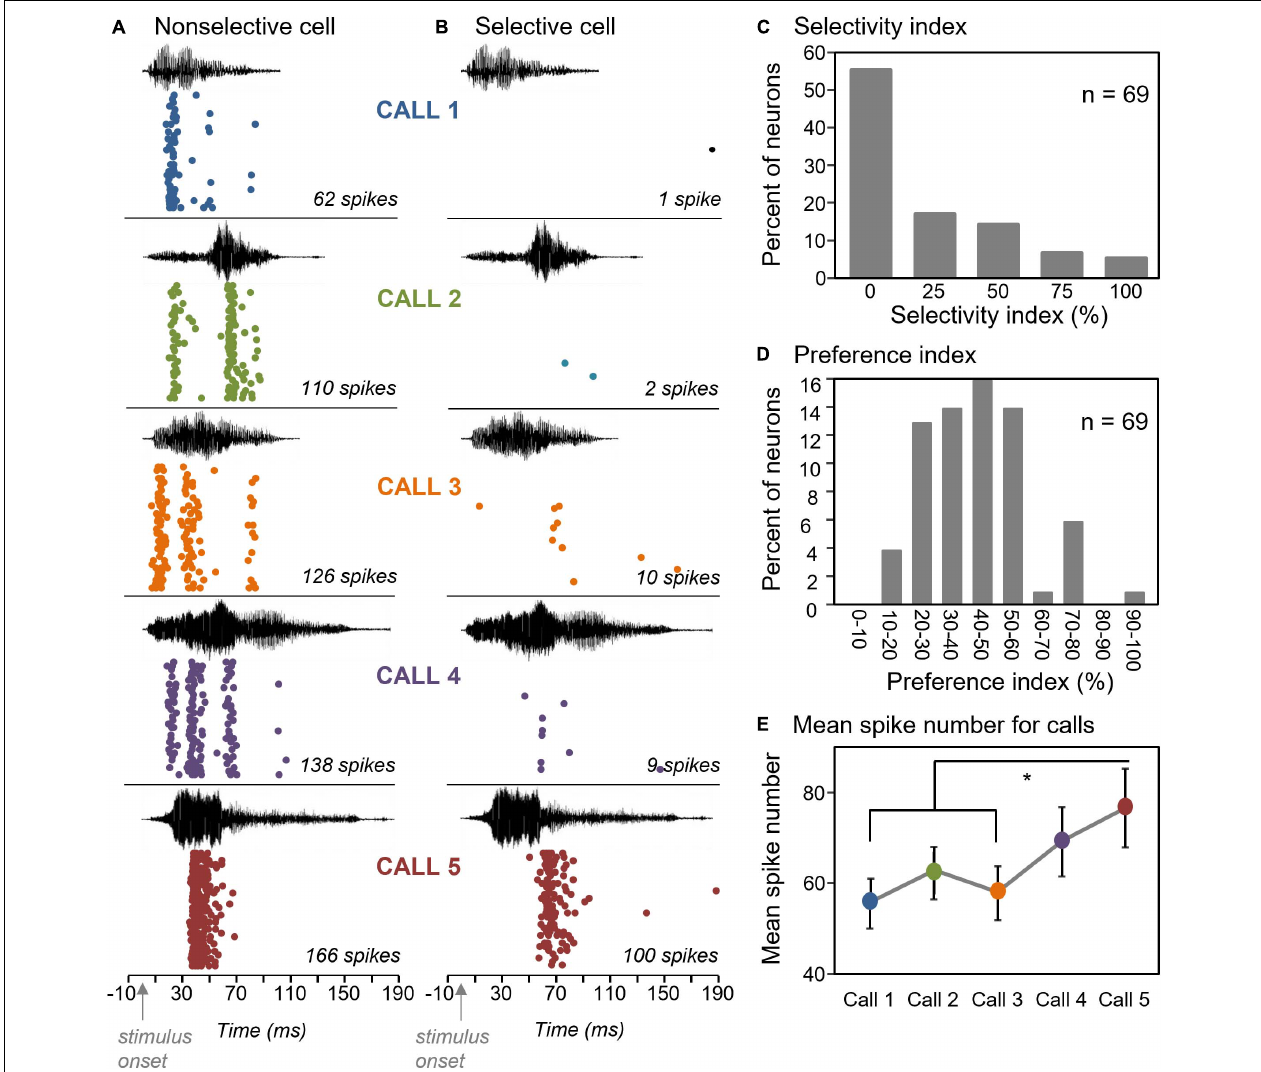
FIGURE 2 | Selectivity of IC neurons for the five BBVs. (A) Raster plots of a neuron that responded to all five BBVs. (B) Raster plot of a neuron that responded robustly only to Call 5. (C) Selectivity index across a group of 69 neurons illustrating a low degree of selectivity, with most neurons responding to all calls. (D) Preference index, showing the mean per cent difference in spiking among pairs of calls across a group of 69 neurons. (E) Mean spike counts for responses across calls show significant differences, with Calls 1 and 3 evoking fewer spikes than Call 5. * p < 0.05.